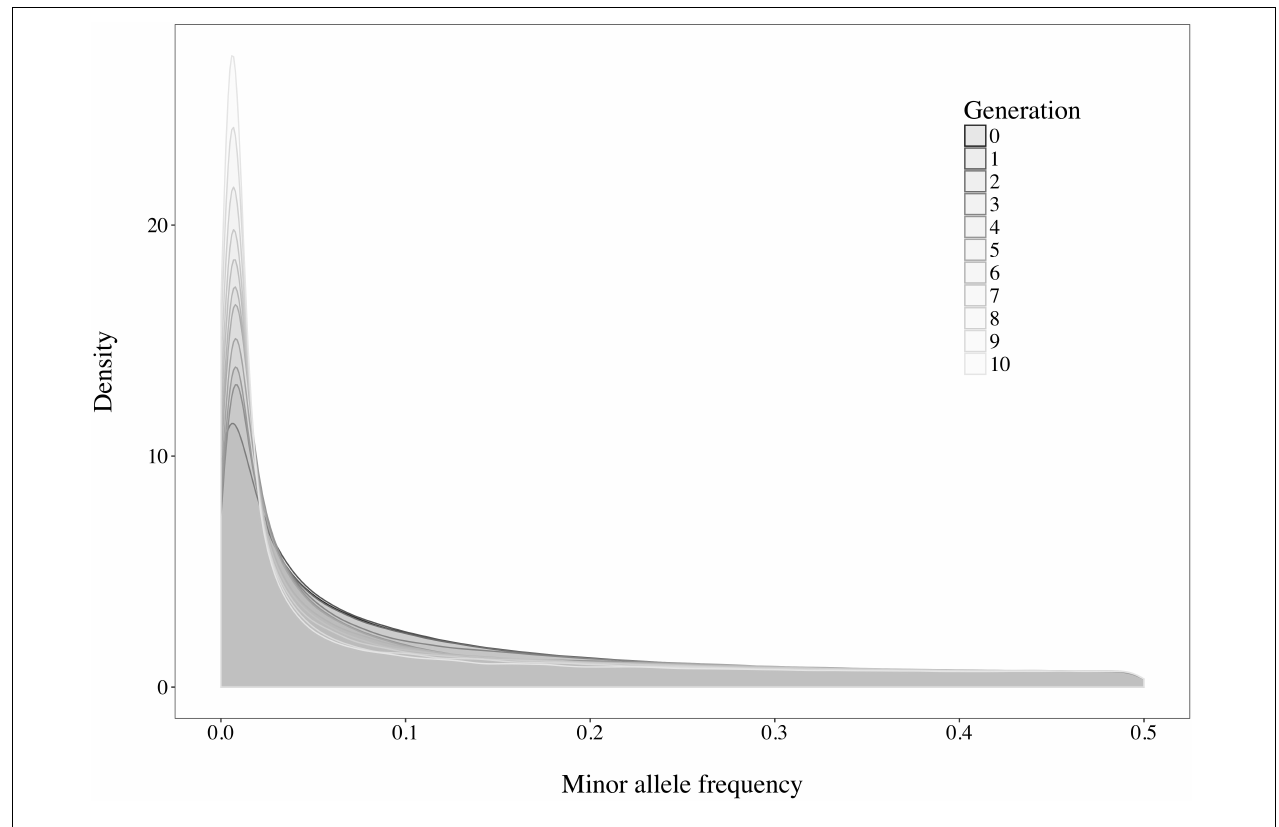
FIGURE 7 | Density curves of the minor allele frequencies observed in the simulated population over the